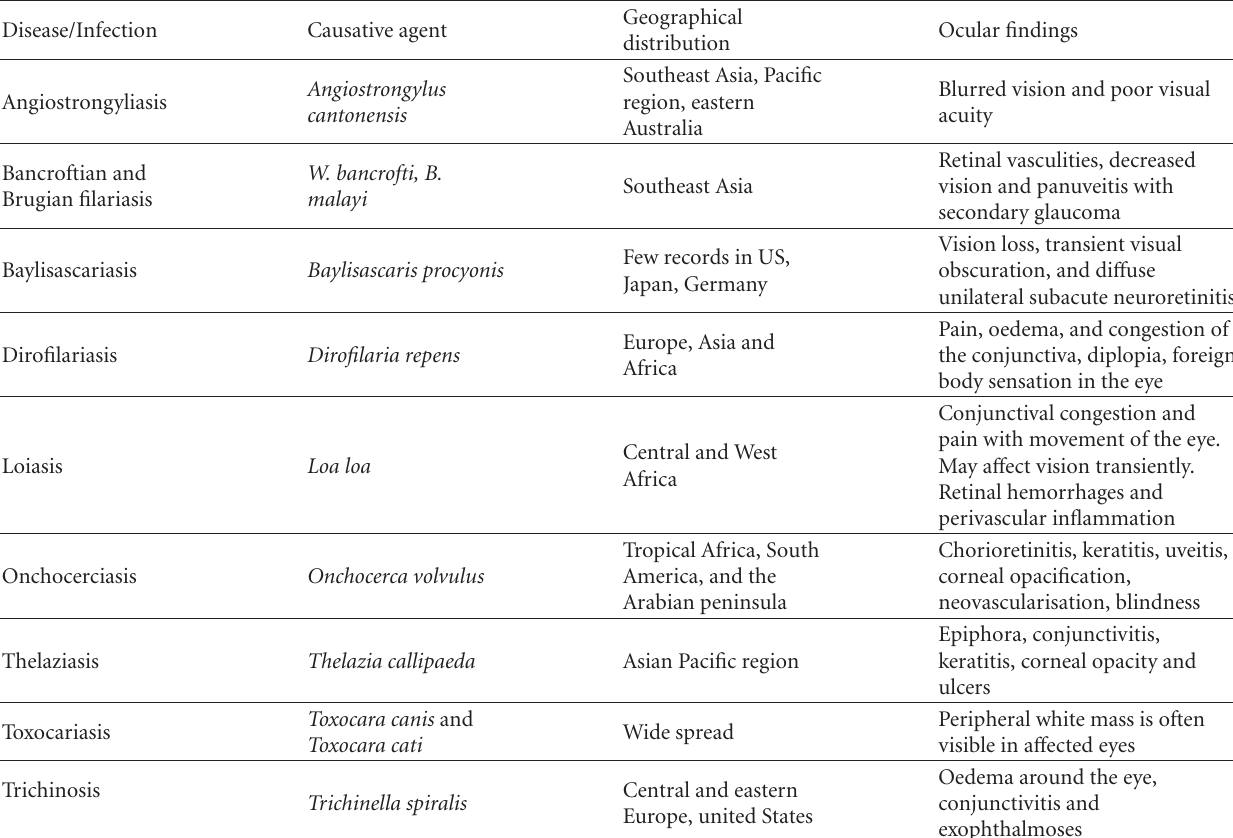
Table 3: Ocular parasitosis caused by round worms ( geographical distribution & ocular findings ).